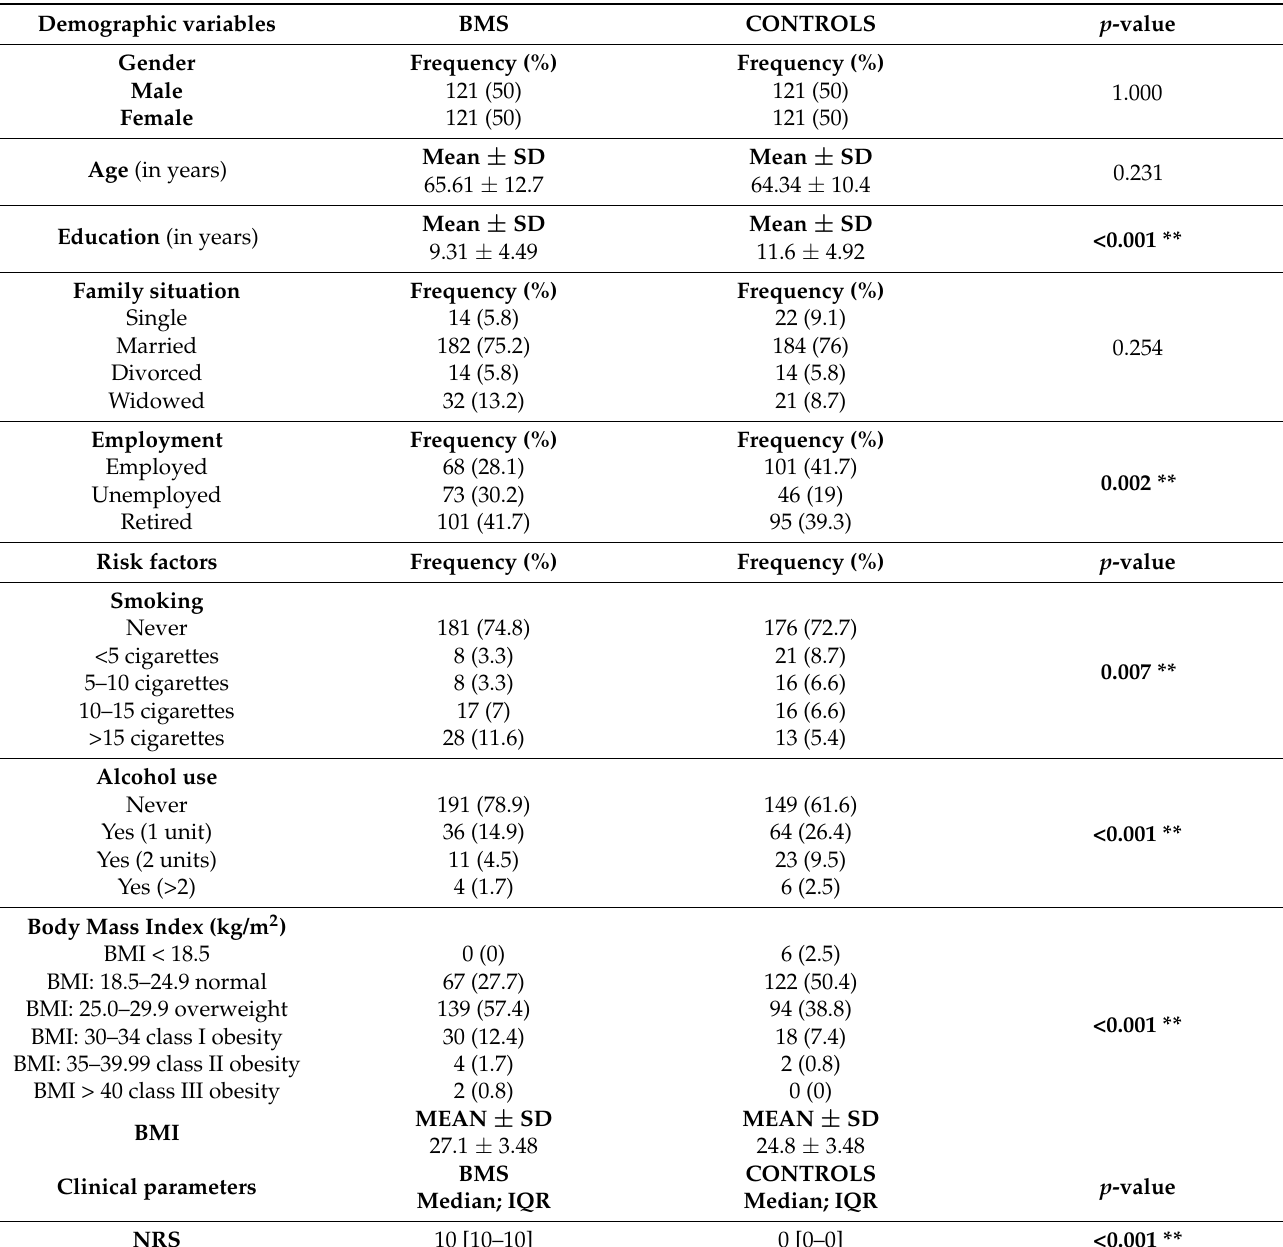
Table 1. Socio-demographic profile, risk factors and clinical parameters of 242 BMS patients and 242